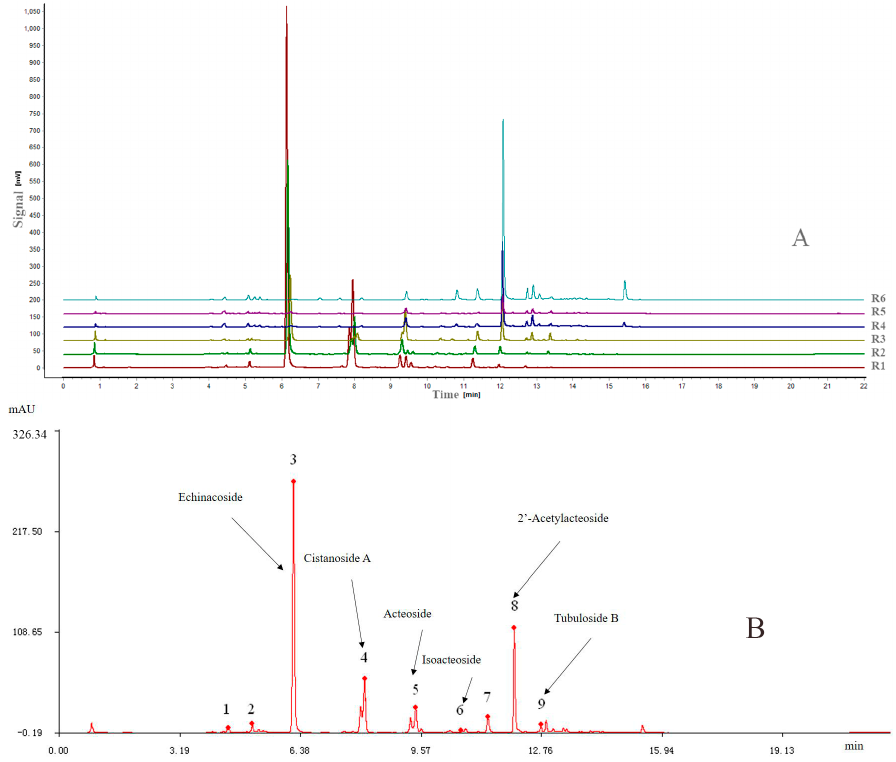
Figure 2. ( A ) Overlaid UPLC chromatograms of samples from Nos. R1–R6; ( B ) the reference chromatogram (marked R) was obtained by using SES for Chromatographic Fingerprint of TCMs.